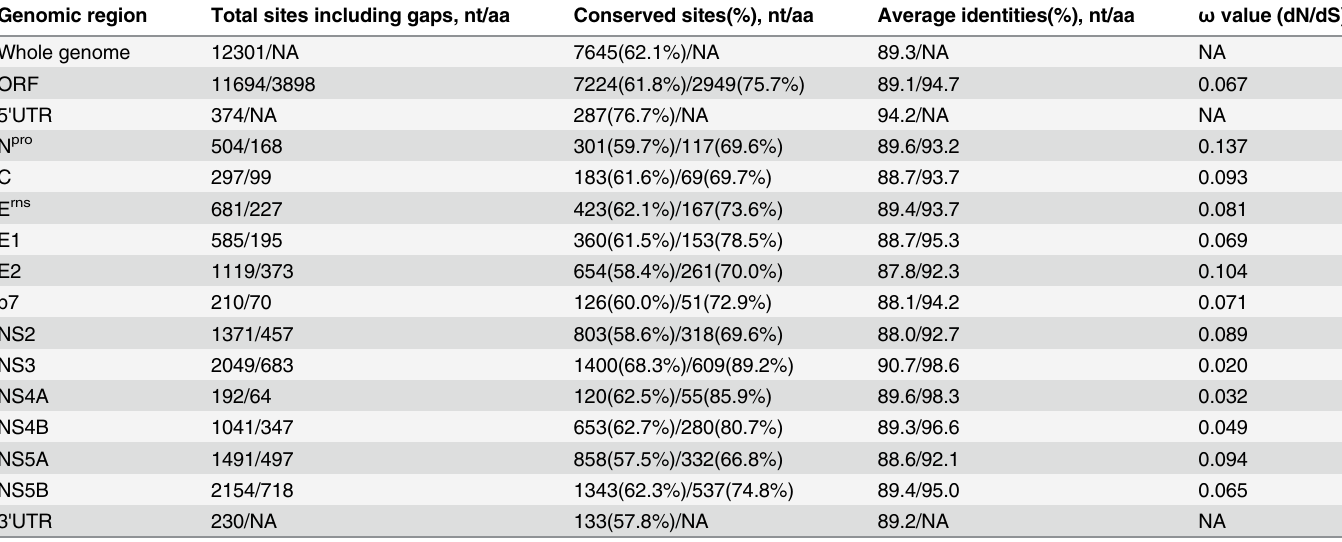
Table 3. Summary of alignment of CSFV genomic regions. Genomic